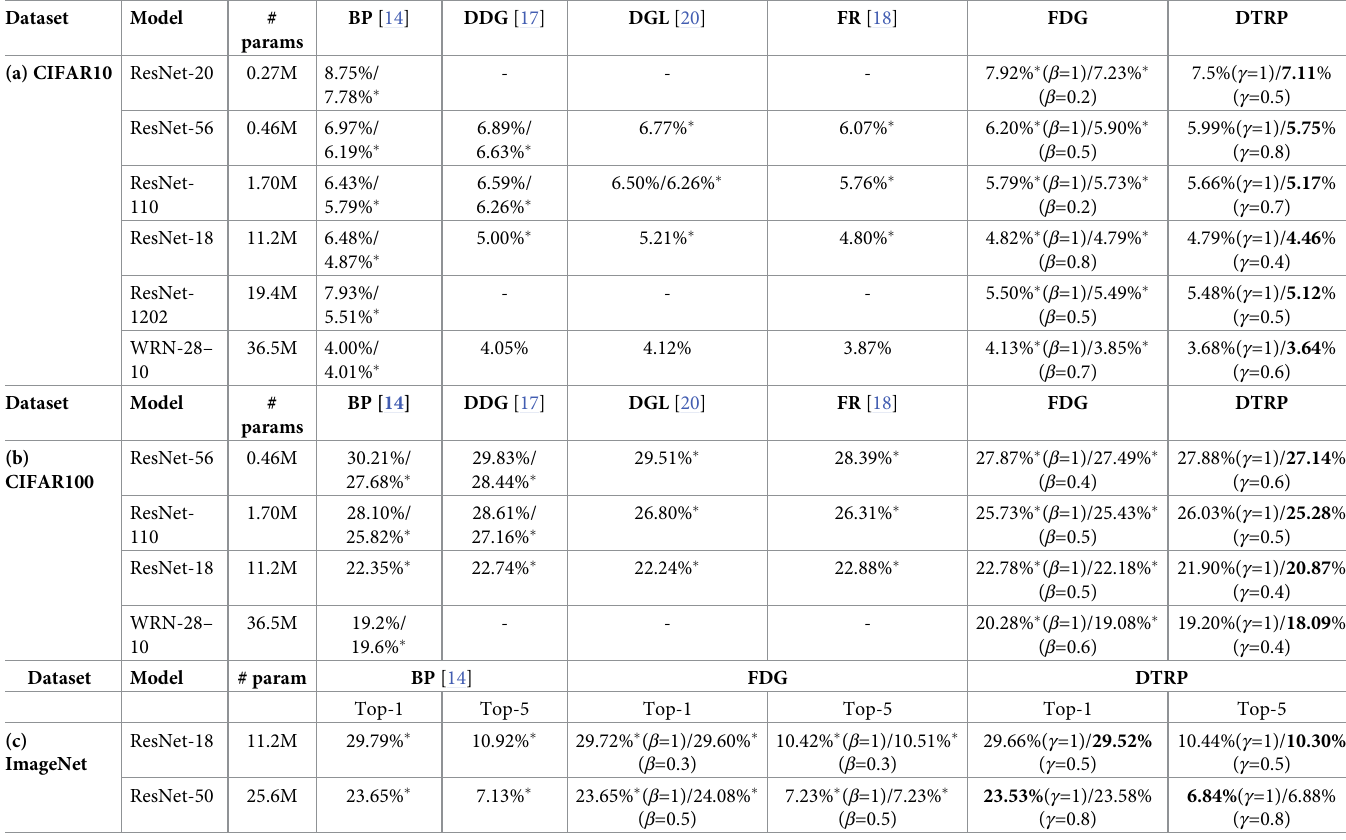
Top-1 errors at the last epoch over 3 times of experiments is taken, the same as that in [21]. • CIFAR10 : Table 5(a) shows the Top-1 errors among various models on CIFAR10 when K = 2. It is observed that without the LRS process ( γ = 1), for ResNet110, ResNet18, ResNet1202 and WRN-28–10, DTRP outperforms other methods including BP. For ResNet20 and ResNet18 the proposed DTRP gives better generalization ability than the BP baselines and produces comparable results against other methods. The adoption of LRS pro- cess increases the robustness of DTRP. Through setting suitable shrinking factor γ , the DTRP outperforms all other methods among all the models. It is also worth noting that Table 5. The validation errors (%) of the compared methods on (a) CIFAR10, (b) CIFAR100, and (c) ImageNet for K = 2. Results with � are rerun using our training strategy, while those without � are the results reported in their original papers [17, 18, 20]. β represents the gradient shrinking factor used in FDG [21] and γ denotes the learning rate shrinking factors in